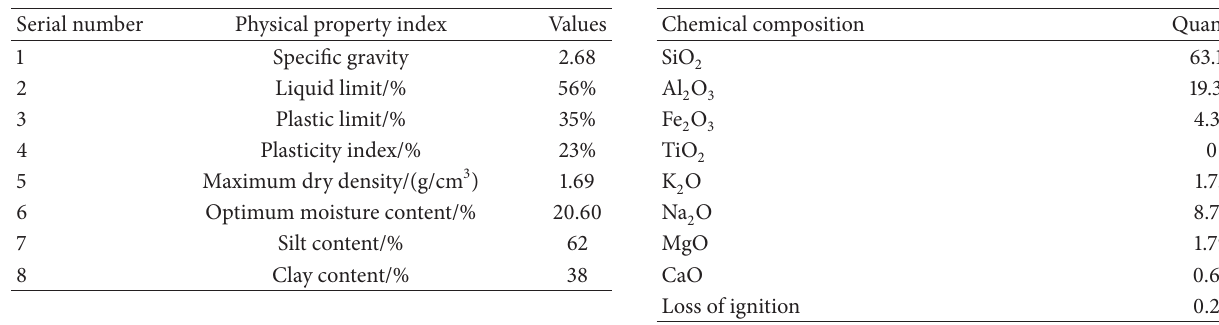
Table 1: Index properties of the soil materials. Table 2: Chemical composition of the soil.